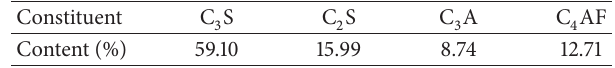
Table 3: System of dry-wet cycling test.